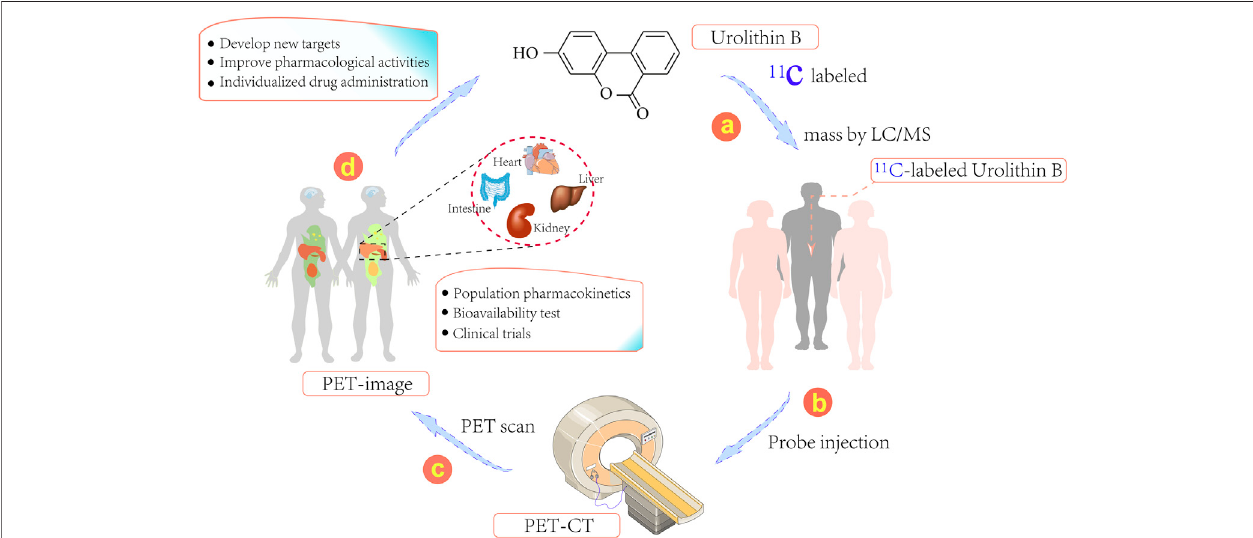
FIGURE 2 | Schematic representation illustrating 11 C-labeled positron emission tomography (PET) for the development and use of Urolithins. (1) Generation of 11 C-labeled Urolithins, (2) Injection of 11 C-labeled Urolithins into patients, (3) PET images effectively captured using the PET-CT imaging system, (4) Discovery of new targets, individualized drug therapy or population pharmacokinetics using this